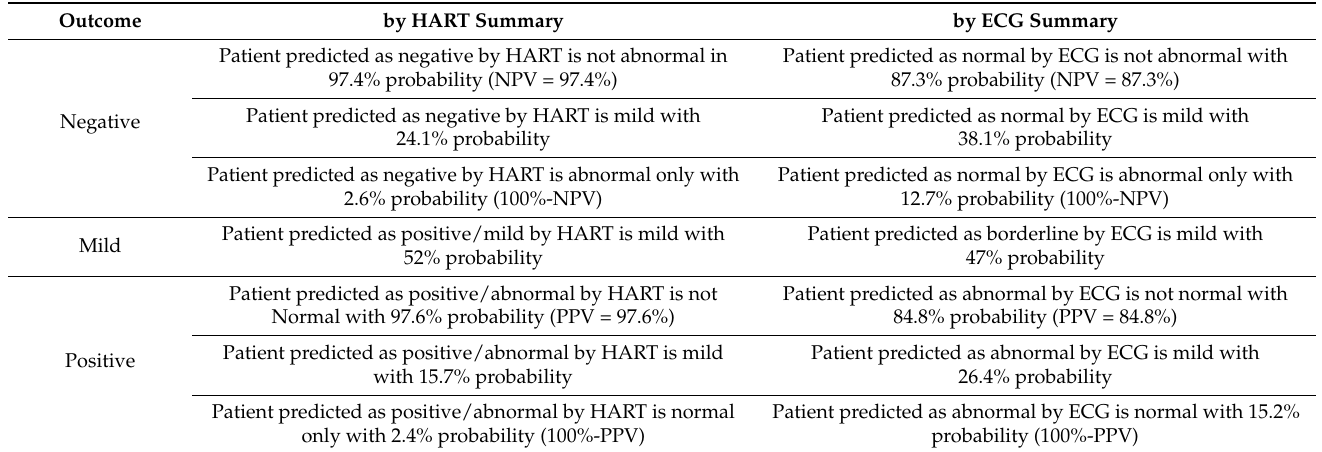
Table 2. Probability evaluation of HART and ECG summary compared to ECHO-based ground